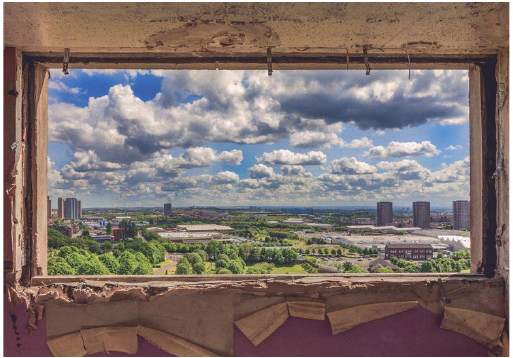
Figure 8 The earthquake-ravaged elementary school building in Miyagi Prefecture, Japan. (Photo by the Author)